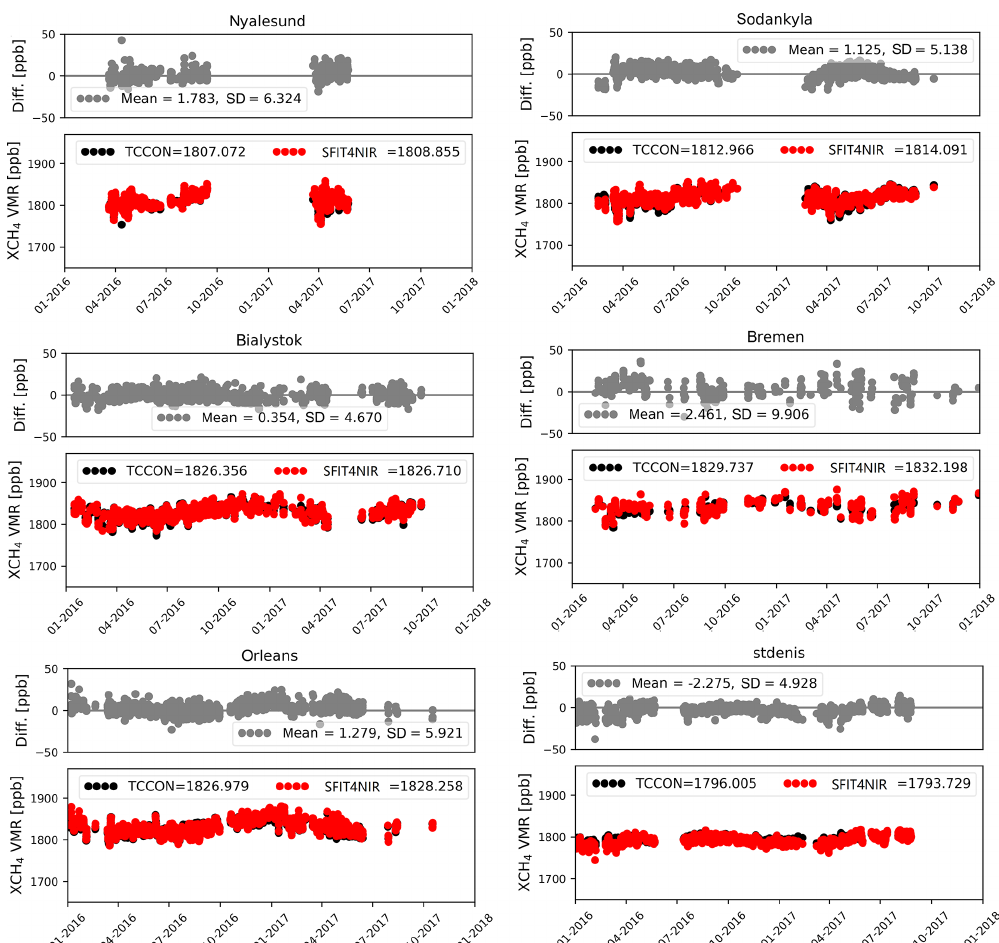
Figure 5. The time series of hourly means of X CH from the SFIT4NIR and the TCCON retrievals at six TCCON sites during 2016–2017, 4 together with their differences. For each site, the lower panel shows the time series of SFIT4NIR and TCCON measurements, and the upper panel shows the absolute difference between them (SFIT4NIR–TCCON; in ppb units). The values in the legend of the lower panel are the means of the TCCON and SFIT4NIR